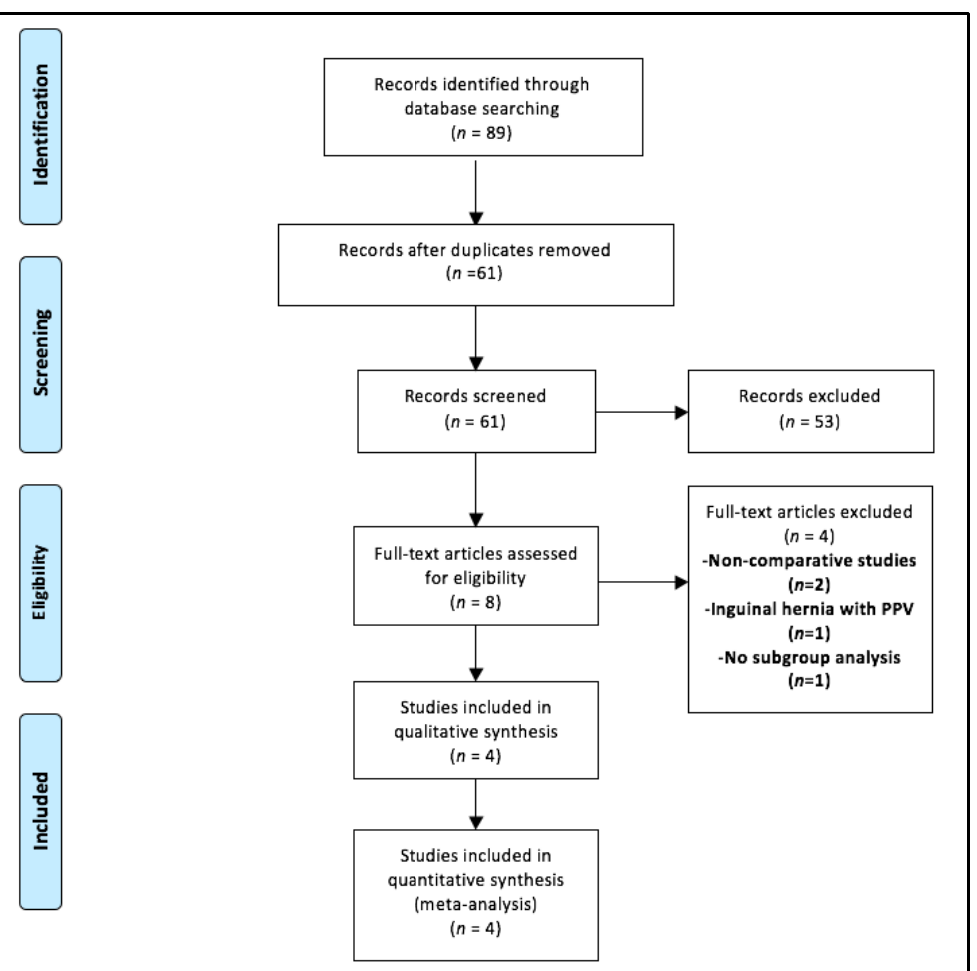
Figure 1. Selection of the relevant studies using the Preferred Reporting Items for Systematic Review and Meta-Analysis (PRISMA) flow diagram. Legend: PPV—patent processus vaginalis. Table 1. Baseline characteristics of the included